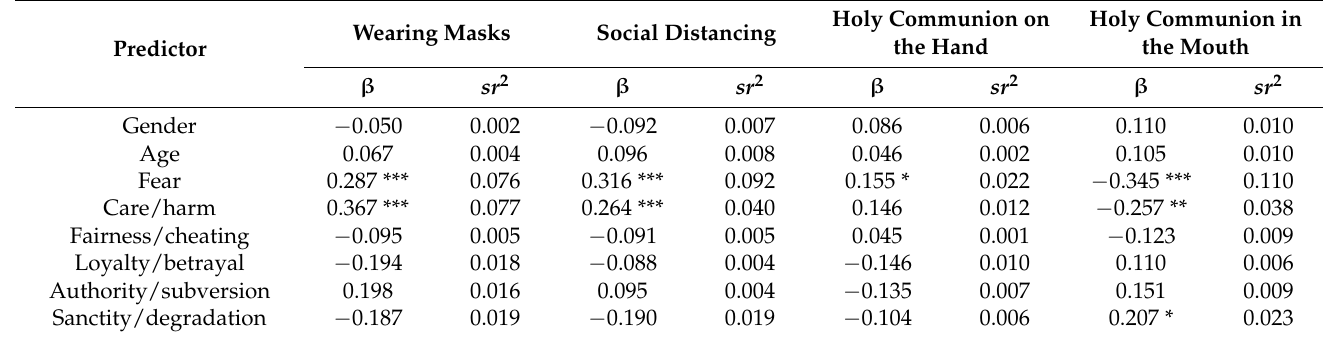
Table 4. Descriptive statistics for the study 1